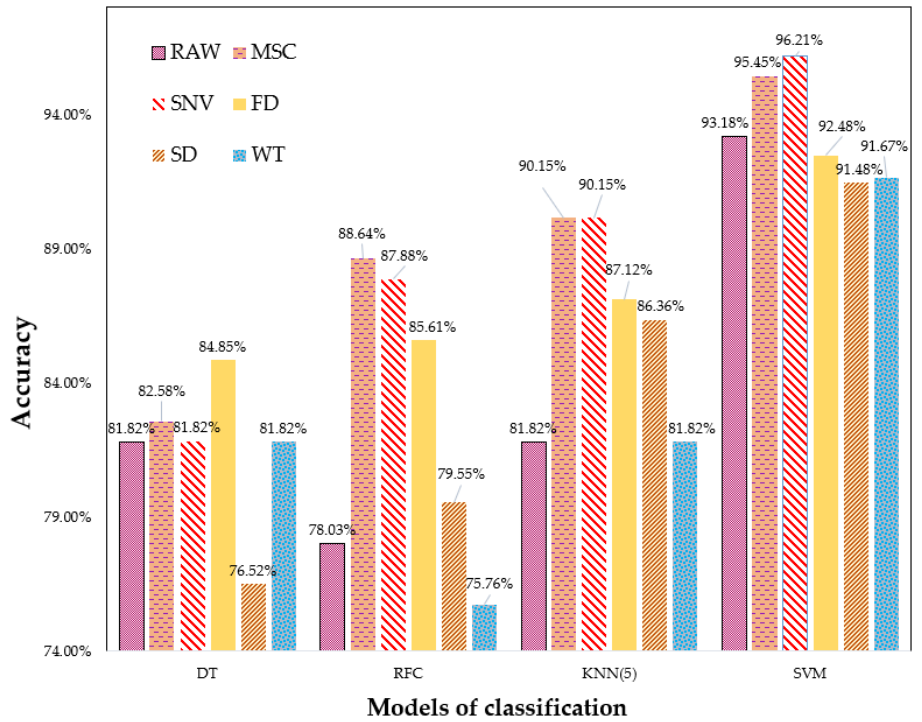
Figure 6. Results based on different models of various preprocessing methods.